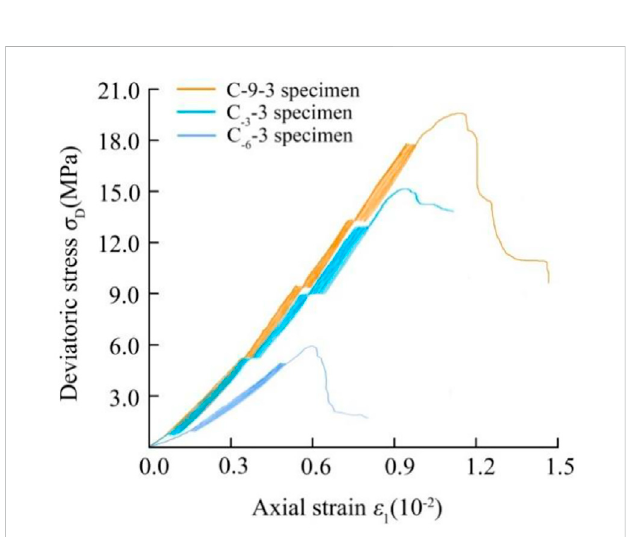
FIGURE 6 The σ D - ε 1 curves of coal specimens with cyclic loading and unloading at different stress lower limits under different unloading